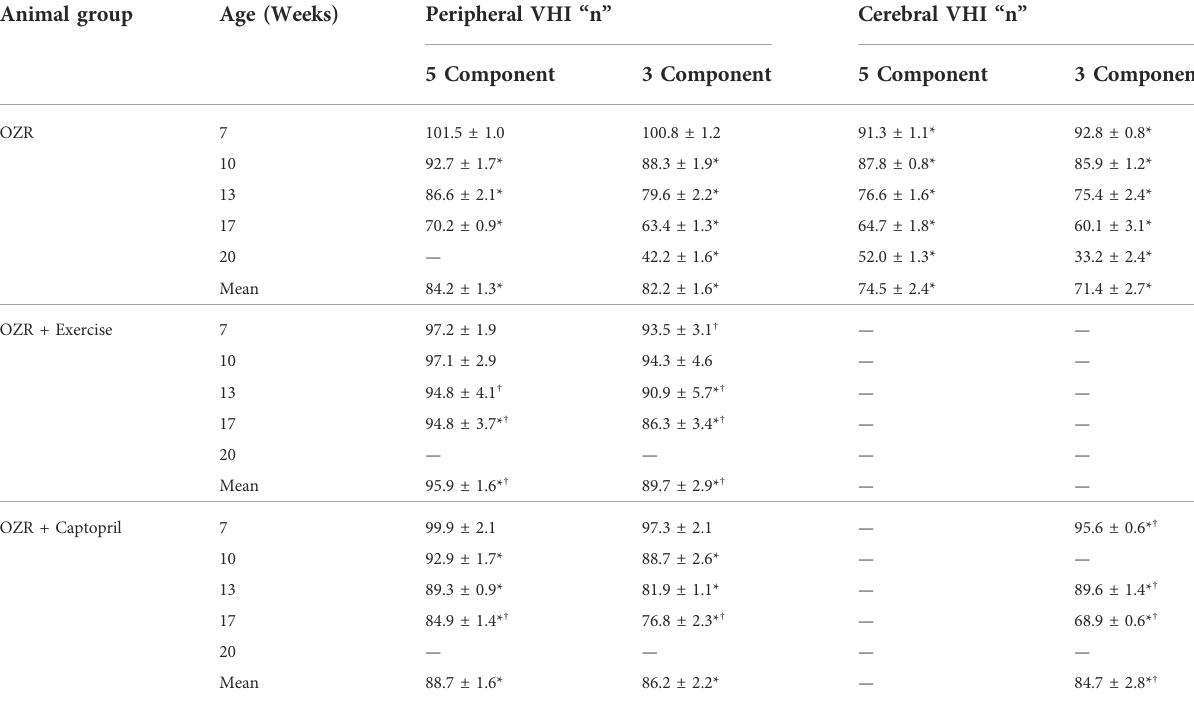
TABLE 6 Calculated Vascular Health Index (VHI) for each group of animals at each age within the present study. Animal